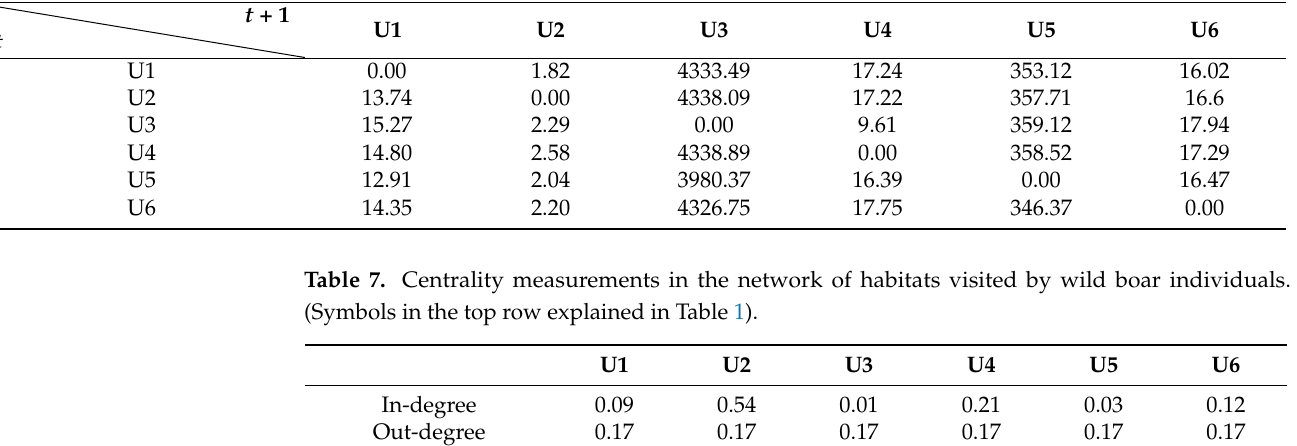
Table 6. First hitting time from each of starting to arriving habitat (Symbols in the top row explained in Table 1).